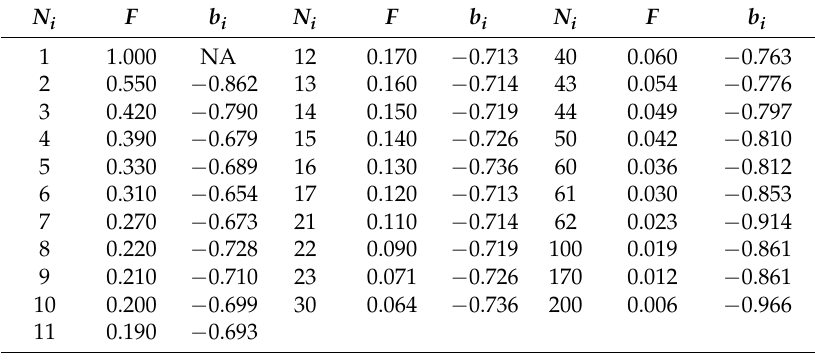
Table 1. Accumulated frequency of road accidents with N deaths digitized from Oggero et al. [11]. N i F b i